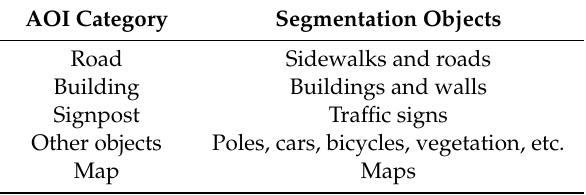
Table 2. The relationship between areas of interest (AOIs) and the segmentation